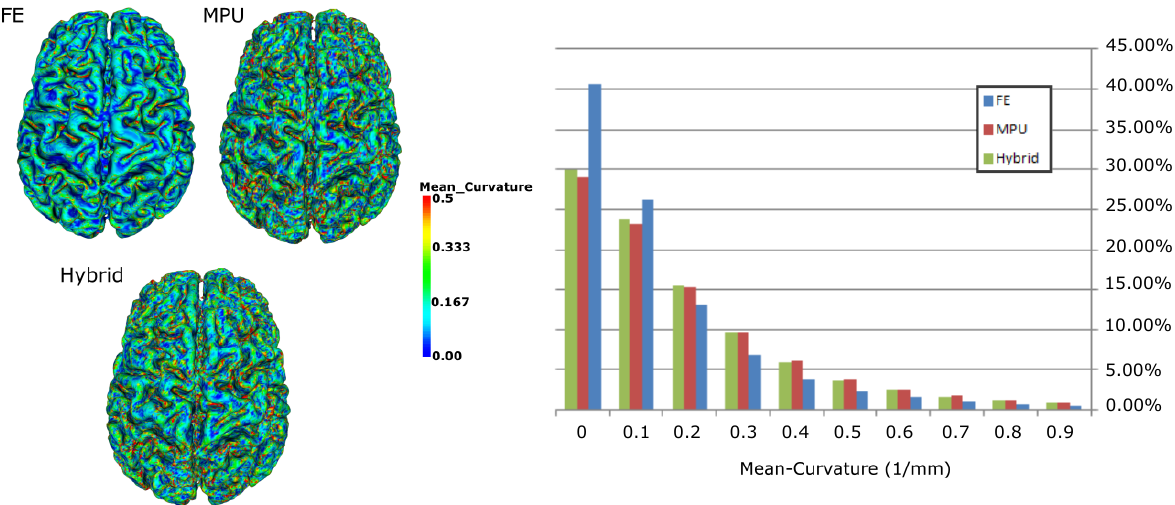
Figure 8. Visualization of the mean curvature on a 3D brain model: ( left ) triangles are colored depending on their curvature value (blue reflects low curvatures and red high curvatures); ( right ) percentage of points as a function of their mean curvature